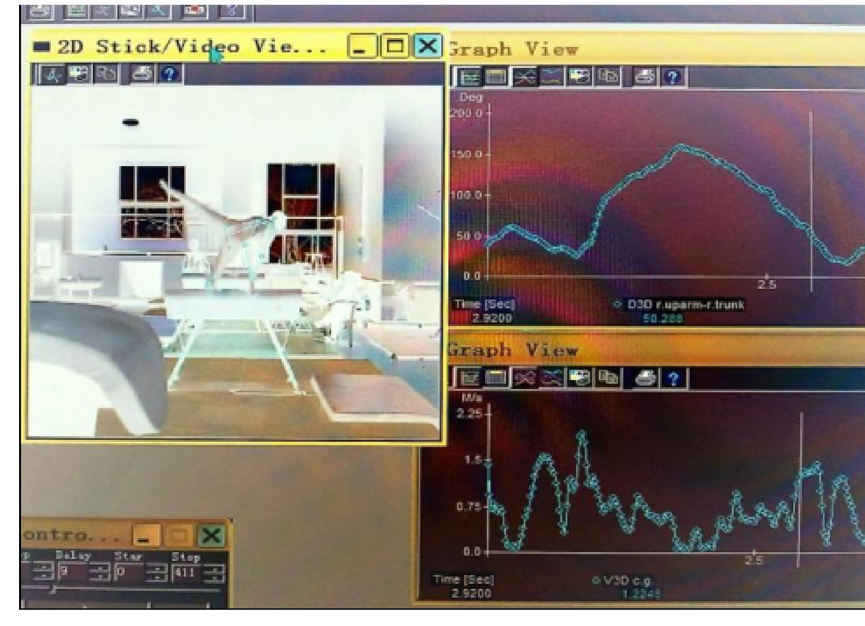
Fig. 10 Shoulder angle and center of gravity speed when the athlete releases his left hand and takes a single arm support when crossing the